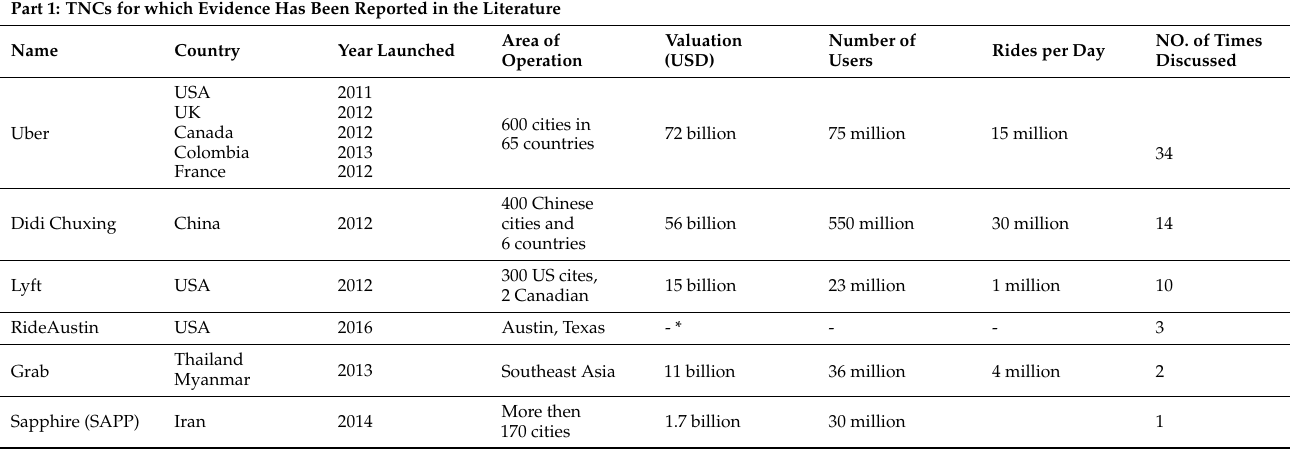
Table 1. TNCs discussed and not discussed in the